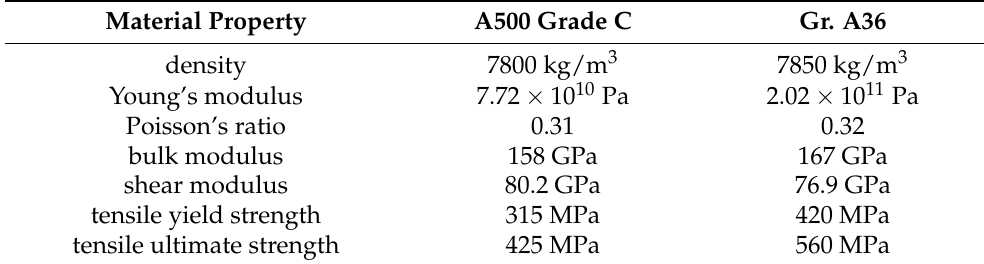
Table 1. Assigned properties for ASTM A500 Grade C and Gr. A36